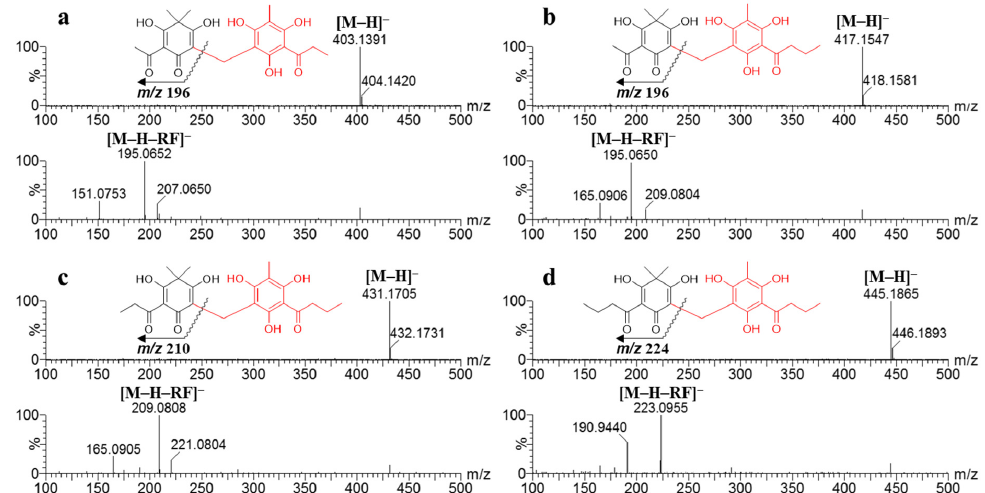
Figure 4. Negative ion mass spectrum acquired by UPLC-ESI/MS and MS/MS analysis of phloroglucinols ( a – d , 1 – 4 , respectively) from rhizomes of Dryopteris crassirhizoma . Abbreviations: RF, residue of a fragment.